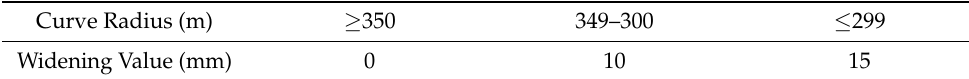
Table 3. Rail gage widening value in Russia (Currently used). Curve Radius (m)